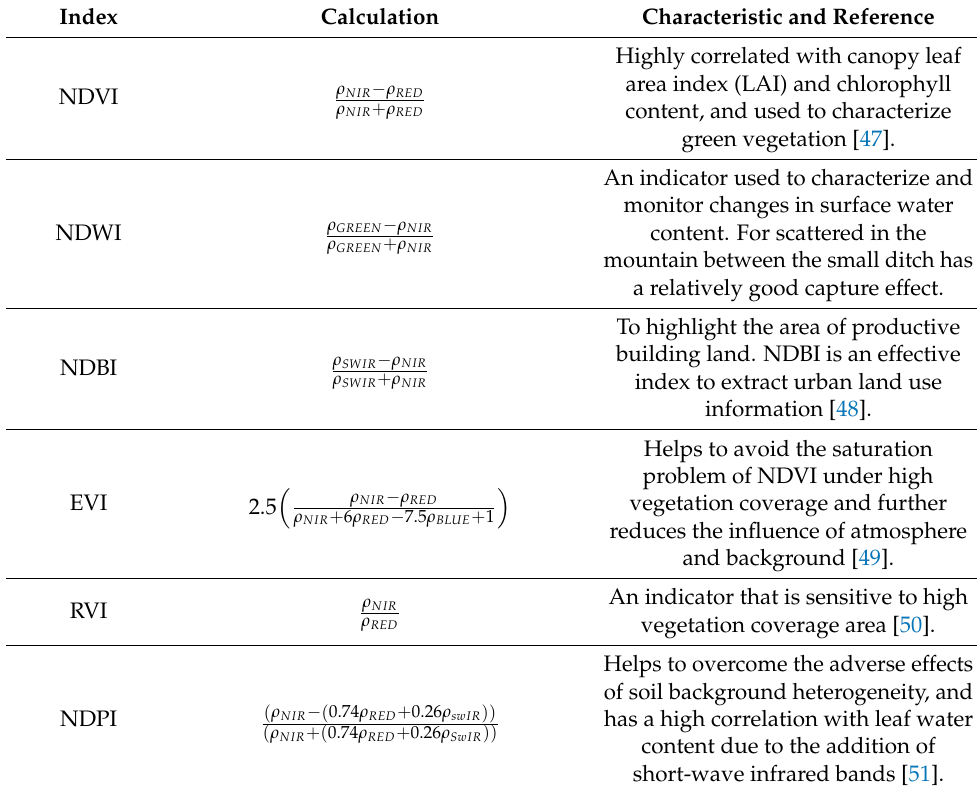
Table 2. Summary table of vegetation indices selected in this experiment.